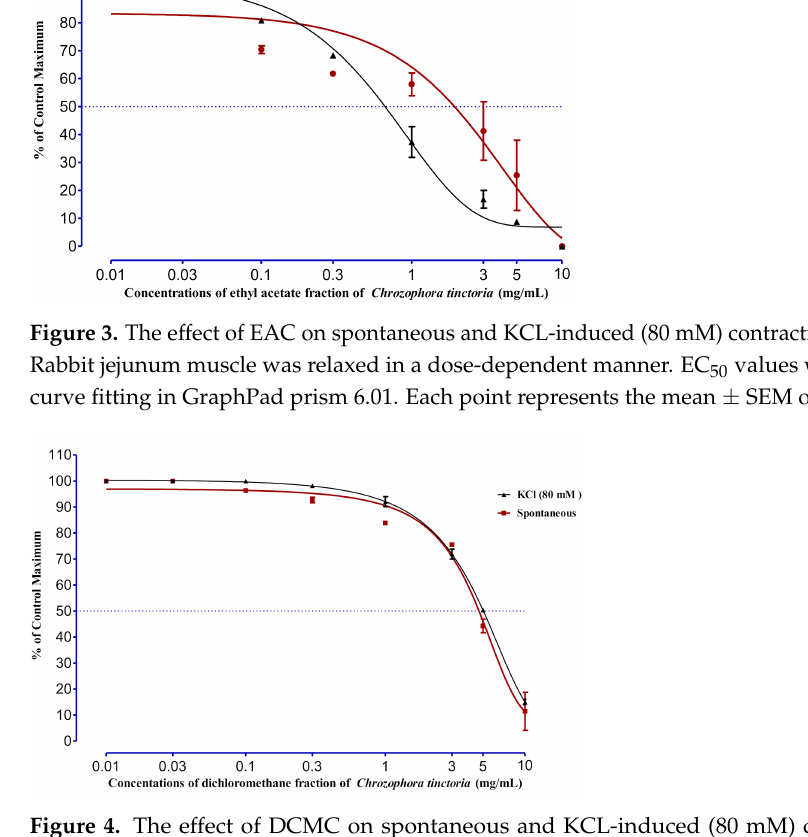
Figure 4. The effect of DCMC on spontaneous and KCL-induced (80 mM) contraction of rabbit jejunum. Rabbit jejunum muscle was relaxed in a dose-dependent manner. EC 50 values were calculated from curve fitting in GraphPad prism 6.01. Each point represents the mean ± SEM of grouped